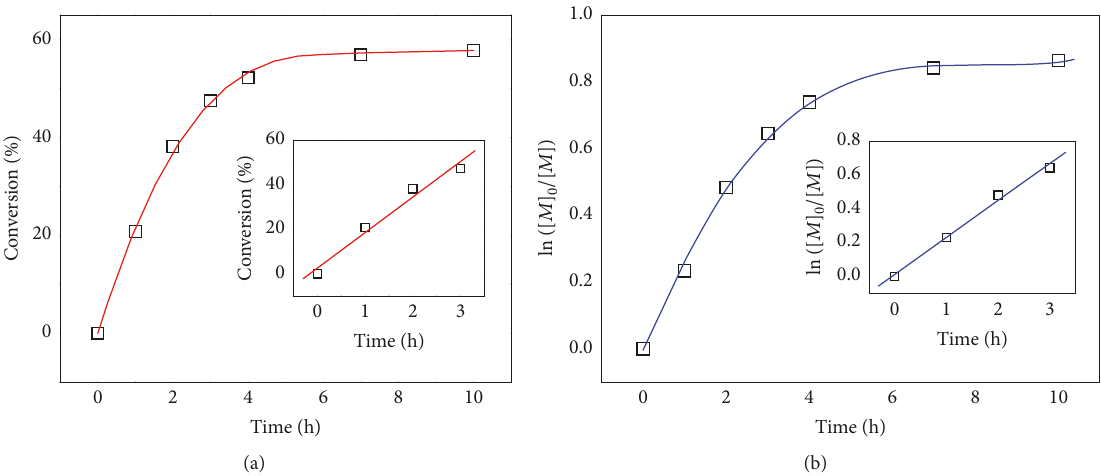
Figure 8: (a) Conversion and (b) kinetics plots for the RAFT polymerization of PLA-PDMAEMA block copolymers with increasing polymerization time (1, 2, 3, 4, 7, and